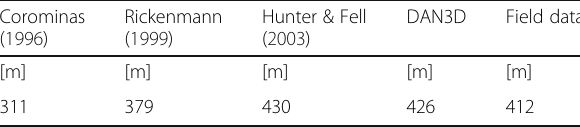
Table 4 Comparison between the calculated and measured runout distances